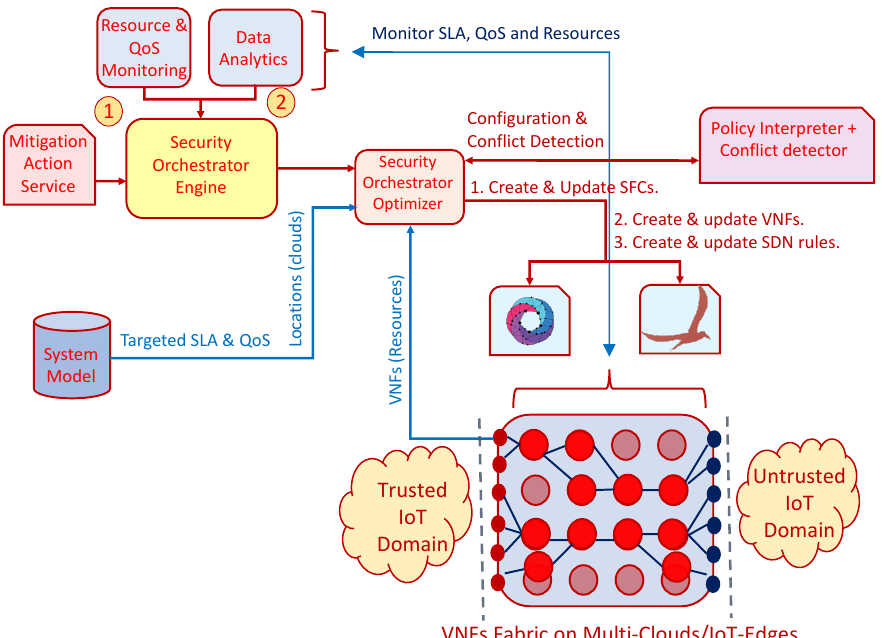
Figure 2. Orchestration system general flow